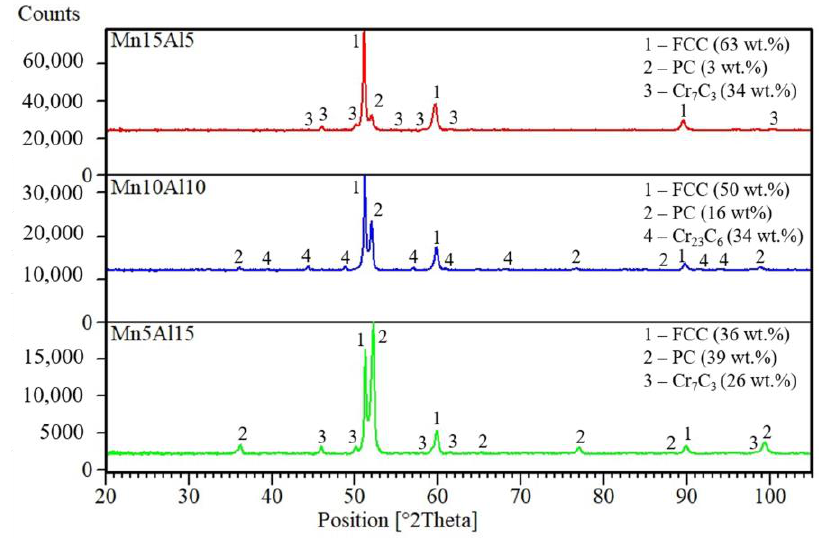
Figure 2. XRD patterns of the MA + SPS compact alloys corresponding to their chemical compositions.